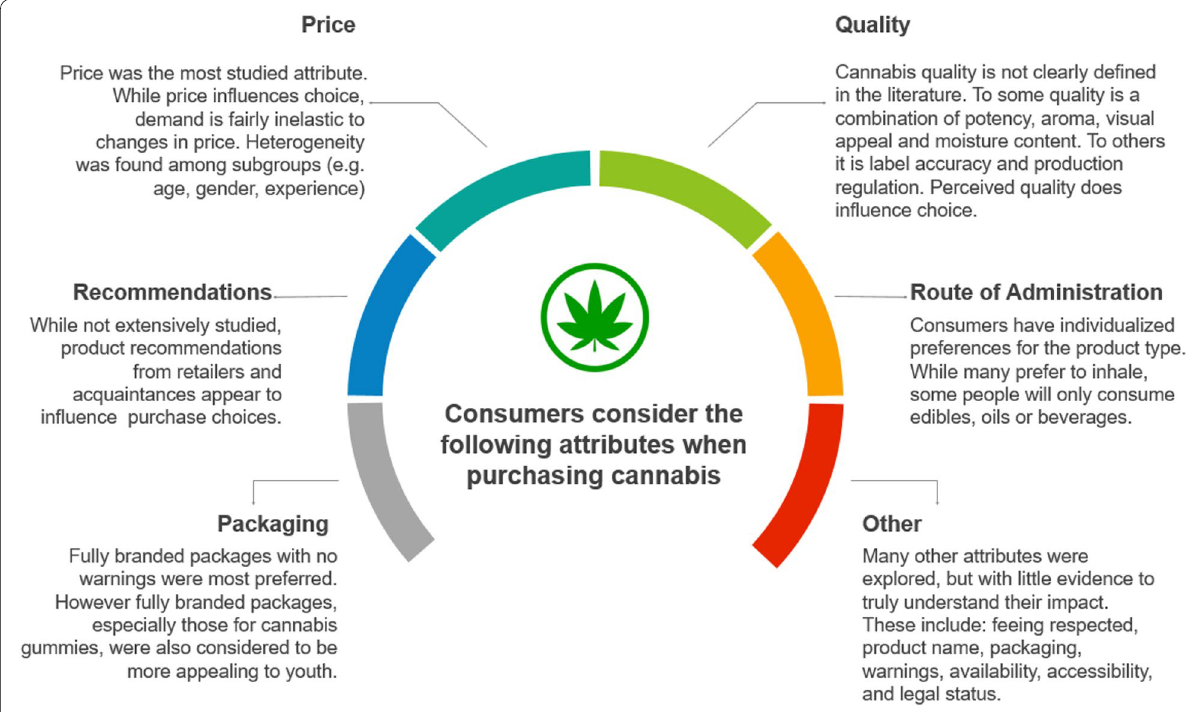
Fig. 2 Emerging themes on attributes of choice for cannabis